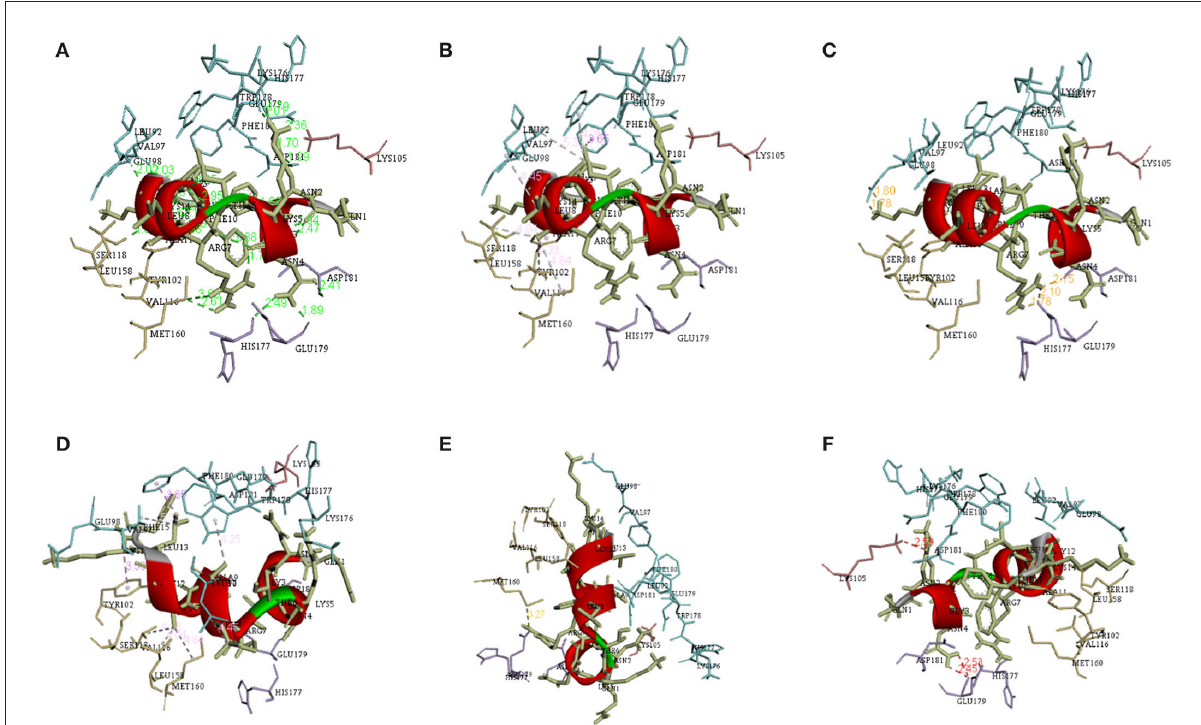
FIGURE4 Different interactions between the epitope and its corresponding MHC allele visualized using the discovery studio. (A) Conventional hydrogen bonds (B) Salt bridge, attractive charge interactions (C) Hydrophobic interactions (D) Cation-Pi interactions (E) Donor-Donor clash (F) Pi Donor hydrogen bond.